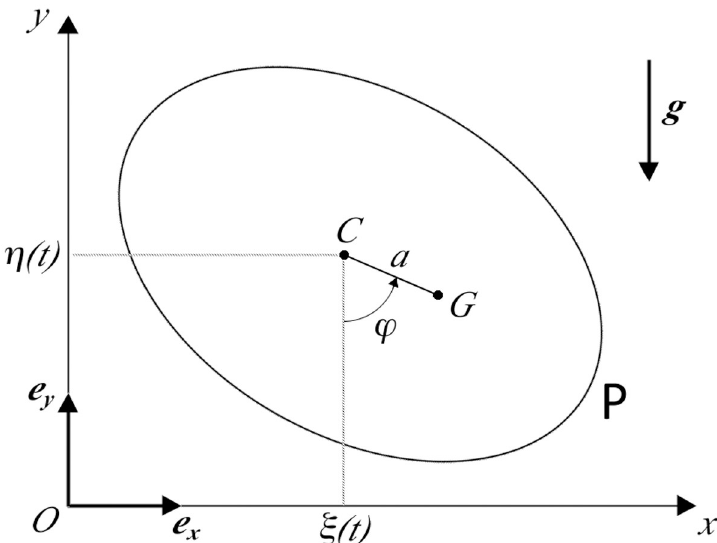
Fig 2. Simple model with tight nail-propeller coupling. A simple model of the device in the case of a tight nail- propeller coupling. C denotes the nail position in the vertical plane Oxy , whose coordinates (ξ , η ) vary according to a given time law. G is the projection on the same plane of the center of mass of the propeller P . Finally, a stands for the (typically small) distance of G from the nail axis and φ is the rotation angle of the propeller. Constraints are assumed to be ideal, but allowance is made for energy dissipation by a viscous term D ¼ (cid:0) b φ _ proportional to the angular φ velocity of the propeller, moving in